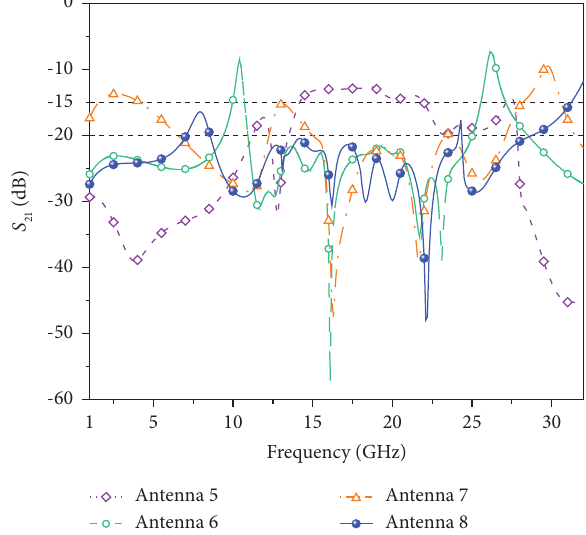
Figure 7: S 21 corresponding to the evolution of the SWB-MIMO antenna